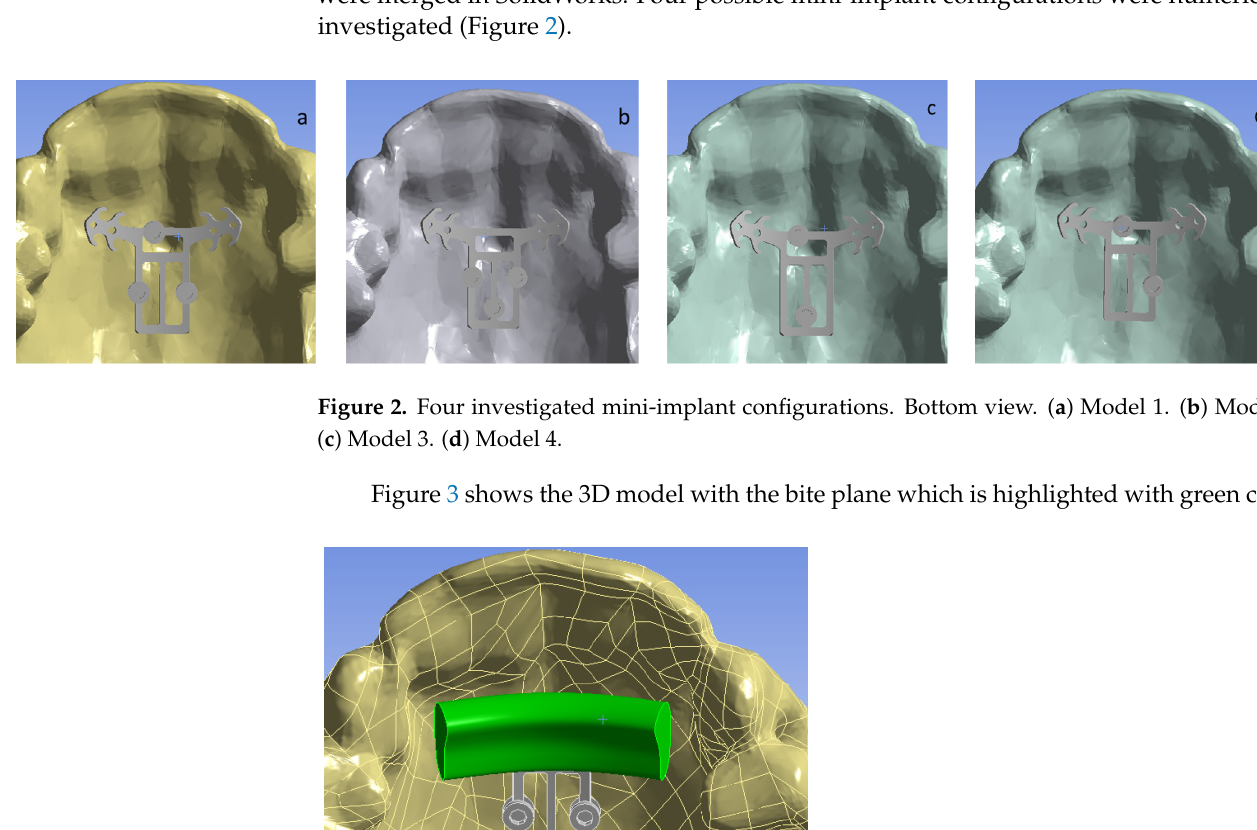
( b ) Figure 1. 3D solid geometrical models: ( a ) two types of jawbone tissue, transparent—cortical bone, yellow—trabecular bone; ( b ) implant of the first configuration (Model 1). The upper jaw 3D surface model was built in Mimics software based on CT data. The